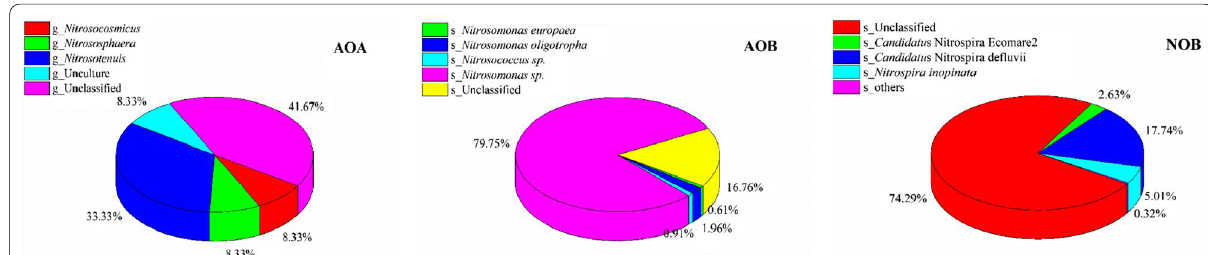
Fig. 5 Community composition of AOA, AOB and NOB based on the dominated